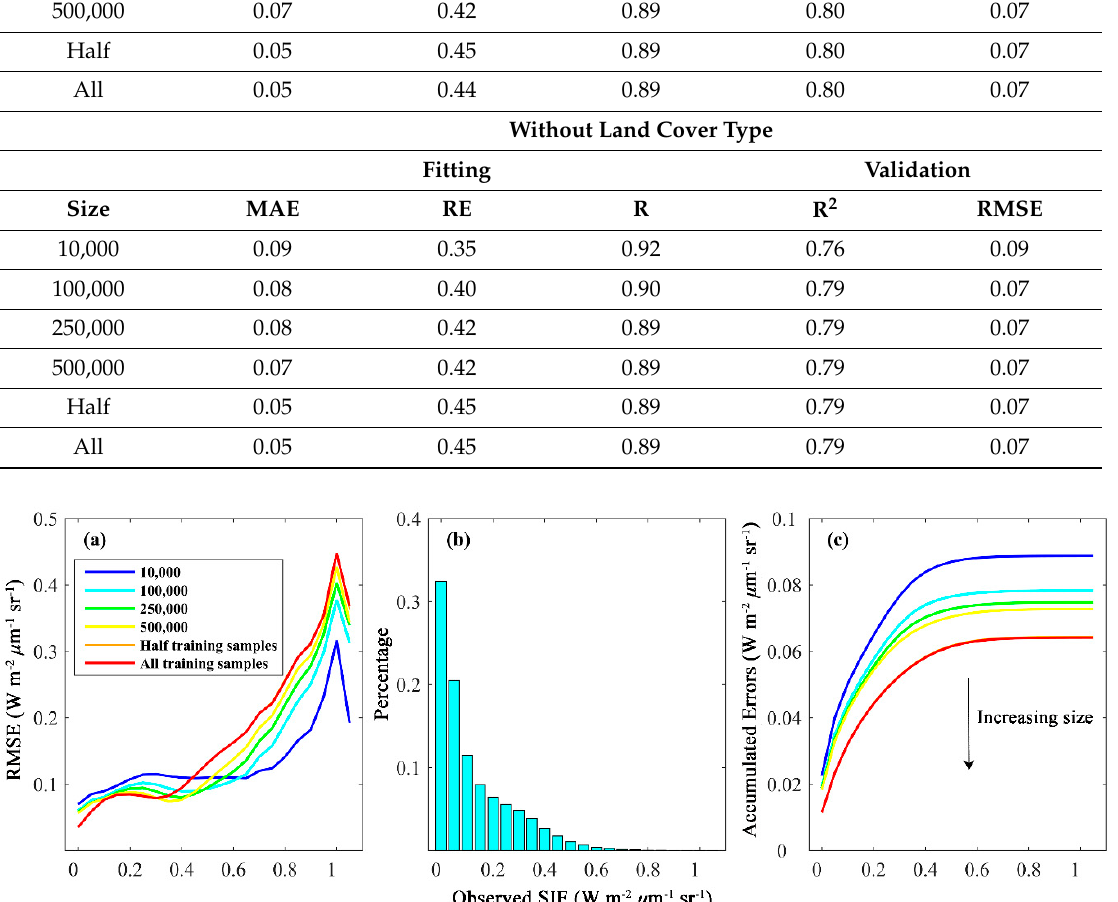
Figure 2. The RMSE between observed SIF and predicted SIF in each 0.05 ◦ SIF interval by different models ( a ). The percentage of each 0.05 ◦ SIF interval relative to all the observed SIF in the test set ( b ). ( c ) showed that the accumulated errors of predicted SIF by different models decreased with increasing sample size.